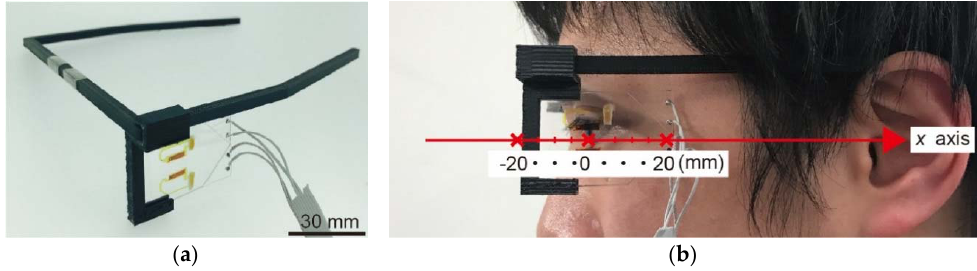
Figure 3. ( a ) Photo of the fabricated smart glass system. ( b ) Photo of the experiments highlighting the position of the system at the x -axis.